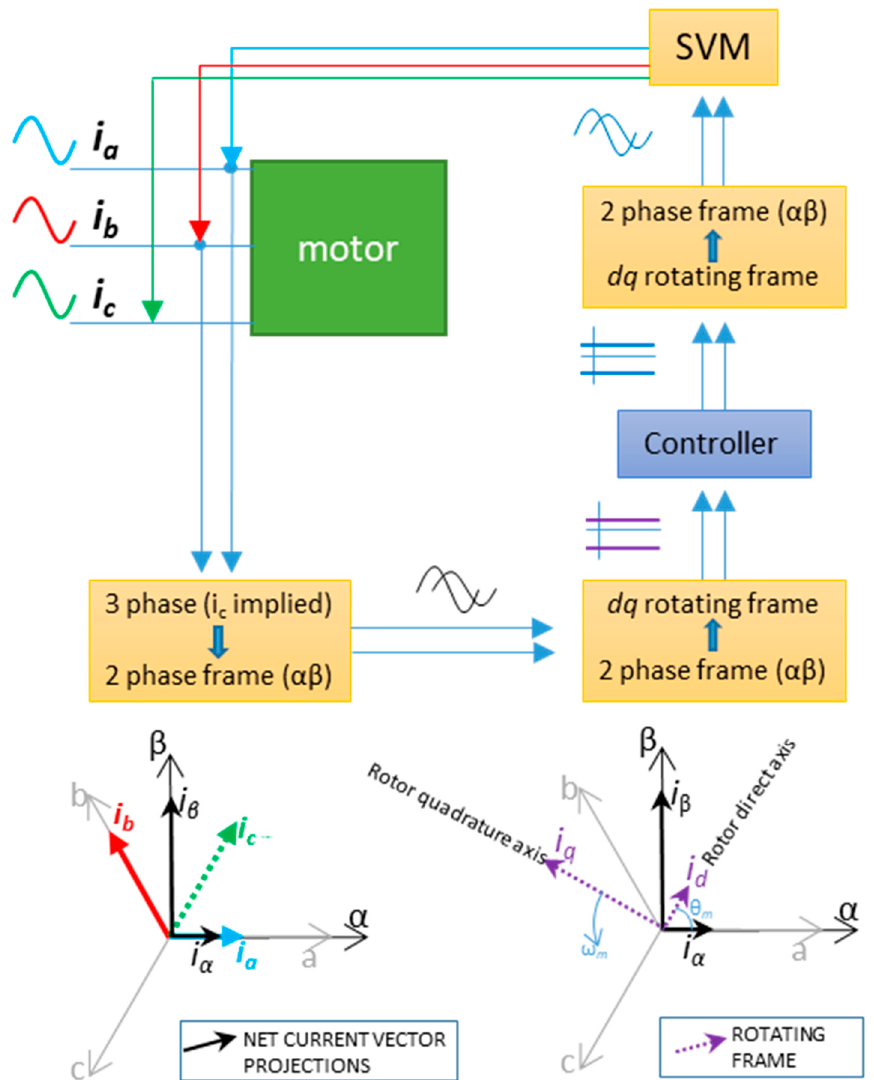
Figure 6. Domain transformations required for the field-oriented controller (FOC) control using space vector modulation (SVM).